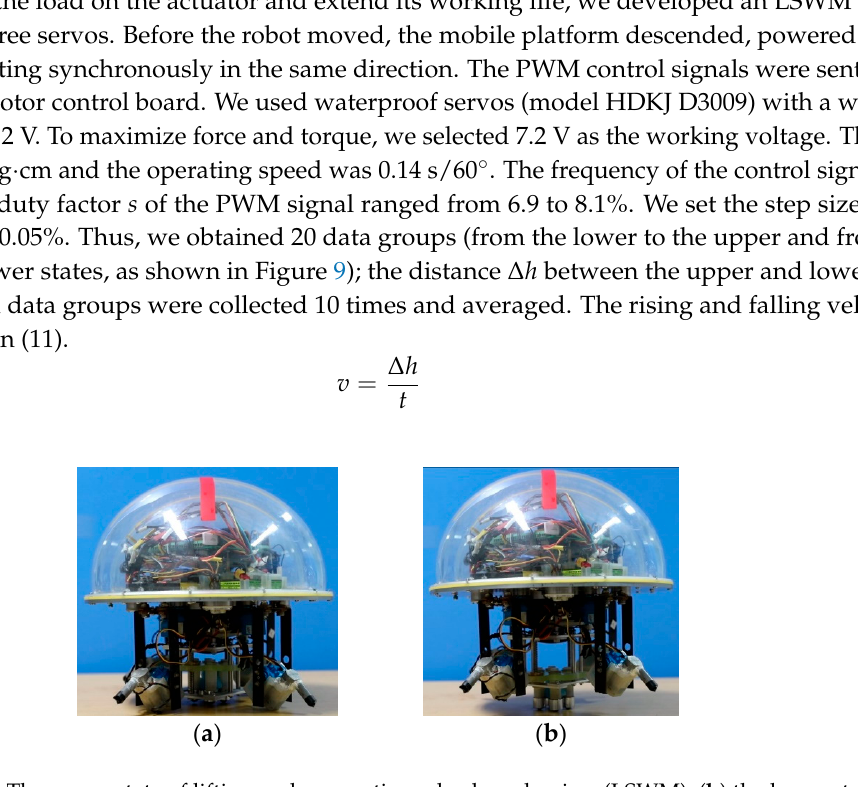
Figure 10. The relationship between the duty factor and the velocity. The falling velocity is positive, and the rising velocity negative .